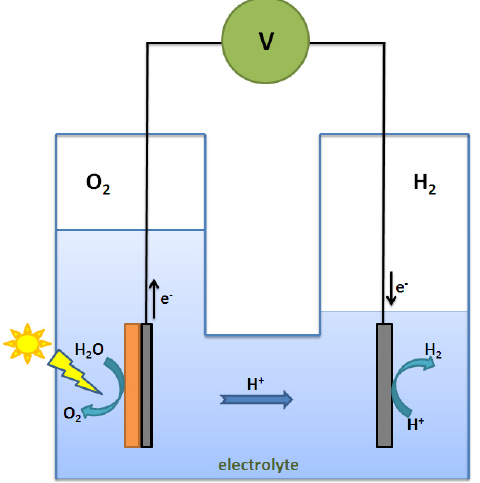
Figure 7. Schematic diagram of a photoelectrochemical